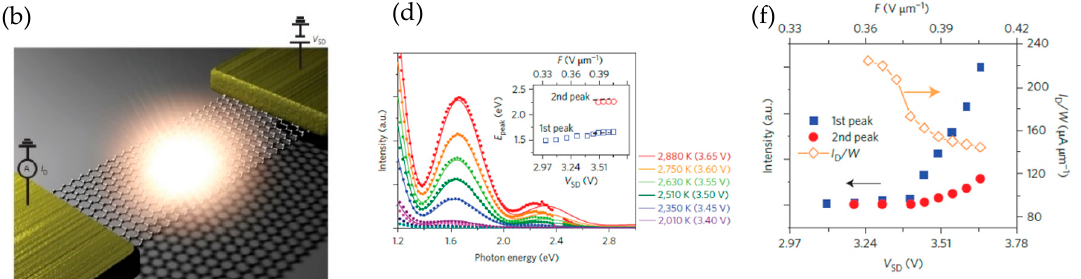
Figure 2. Light emission from suspended graphene: ( a ) shows the single-layer suspended graphene structure, ( b ) illustrates the light emission (hot spot) from the center of suspended graphene at room temperature at (< 10 − 4 Torr). ( c , d ) The emission radiation peaks from the suspended graphene-based structure under applied electric field, ( f ) as a function of V DS, where the dotted line presents the calculated energy of the emission peaks related to the interference effect of thermal radiations. ( e , f ) The integrated intensity referred to the individual emission peak, ( e ) tri-layer, where I d and V DS correspond to the applied electric power and electric field, respectively, as with the increase of V DS, the applied electric power is decreased, whereas the rapid increase in emission intensity was observed [20].